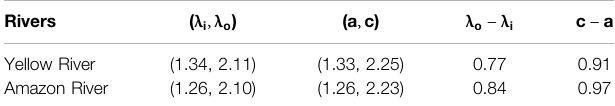
TABLE 1 | The generators ( λ i , λ o ) and Tokunaga parameters ( a , c ) for the Yellow River and the Amazon